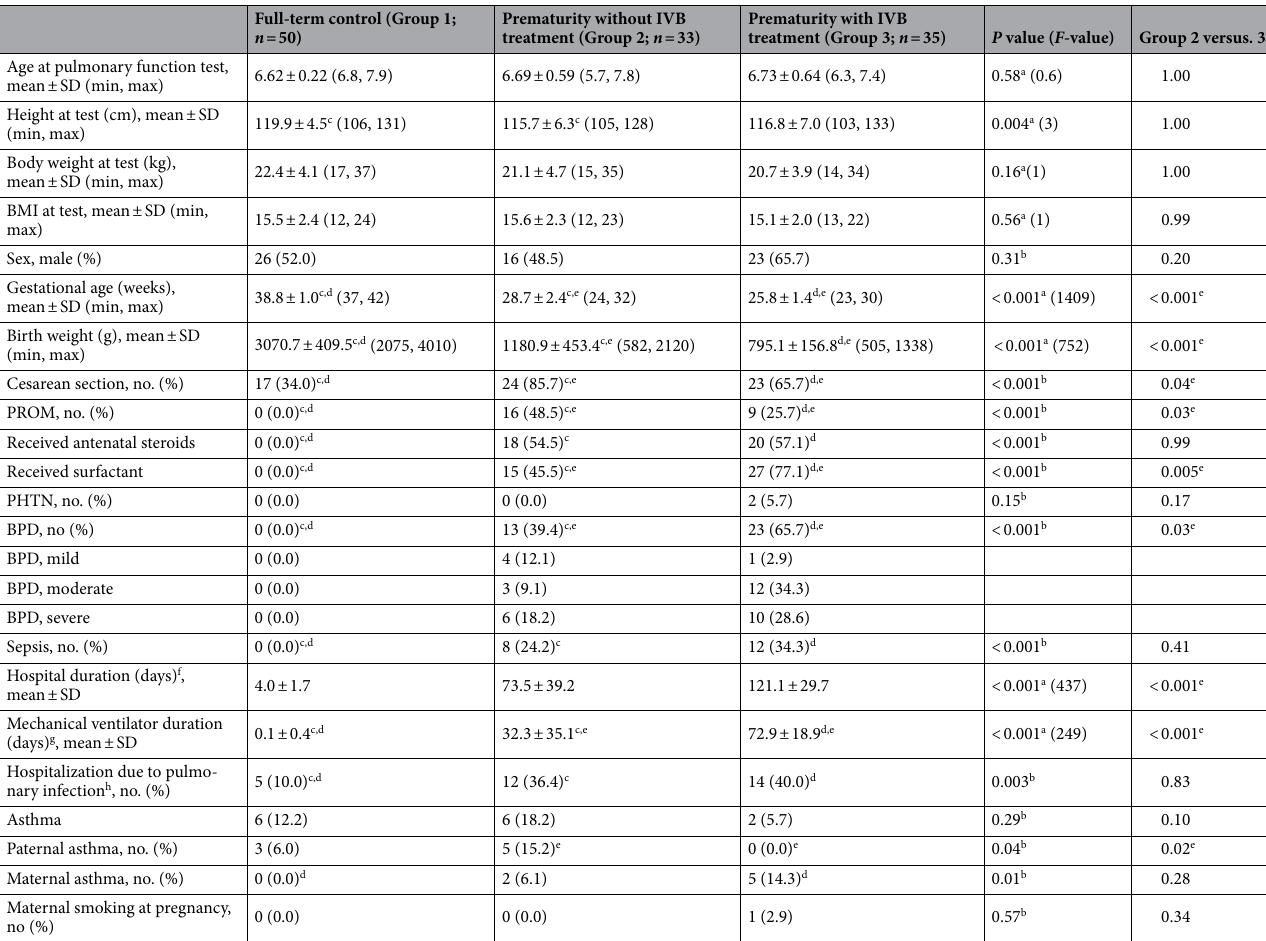
Table 1. Demographics of study participants. BMI body mass index; BPD bronchopulmonary dysplasia; IVB intravitreal injection of Bevacizumab; PHTN pulmonary hypertension; PROM premature rupture